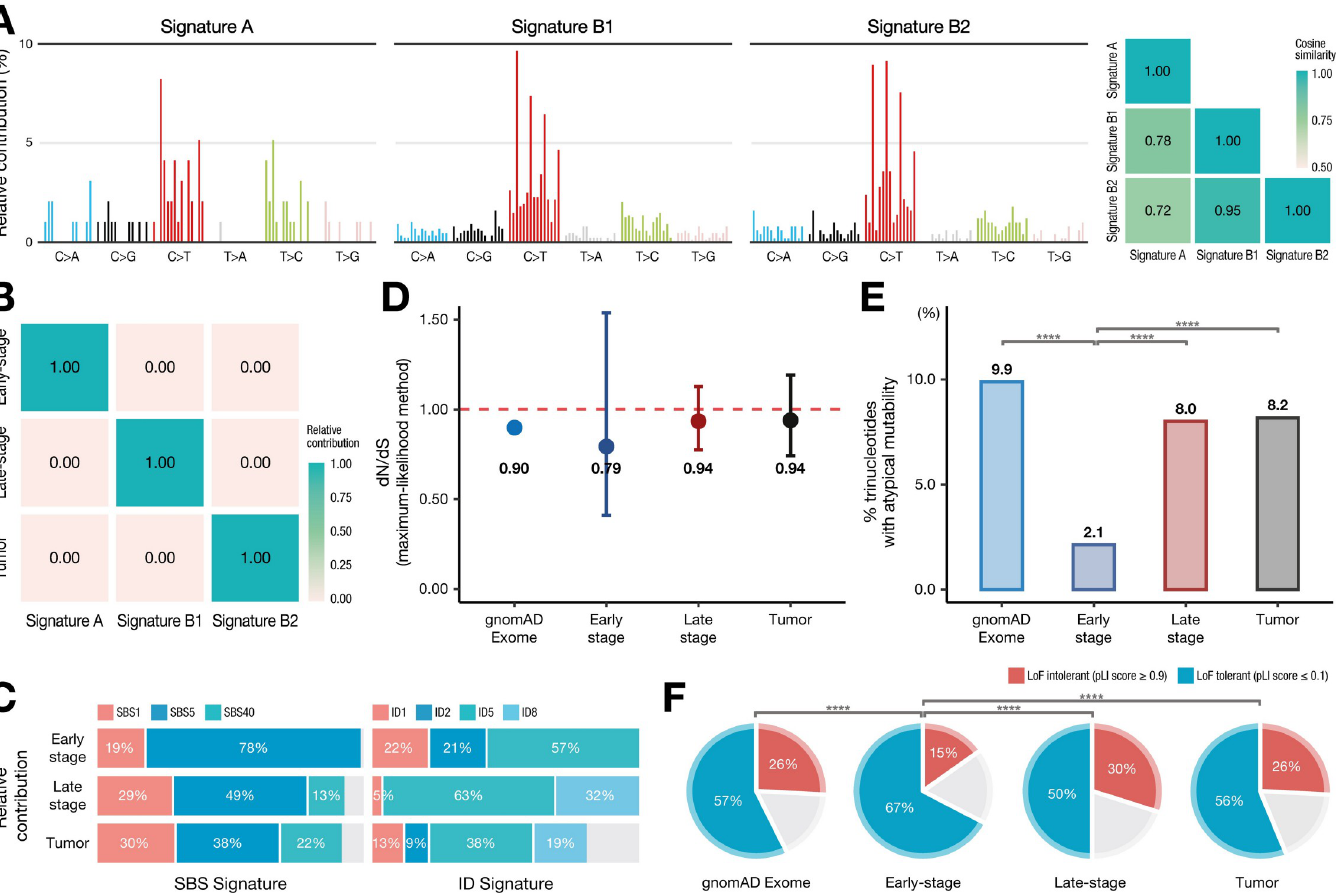
Fig 3. Mutational profiles and functional analysis. ( A) De novo extraction of somatic mutations by non-negative matrix factorization. ( B) Each group was classified according to the three signatures (A, B1, and B2). ( C) The relative contribution of the common clock-like signatures (SBS1, SBS5, and SBS40 for single-base substitutions, and ID1, ID2, ID5, and ID8 for small insertion-deletions) from PCAWG signatures. Mutations from the three groups were extracted as three signatures by NMF. Mutational contributions were obtained by fitting the extracted signatures to the mutations in each group. ( D) The dN/dS score ratios, ( E) proportion of trinucleotides with atypical mutability, and ( F) pLI score for gnomAD Exome and each group are shown.